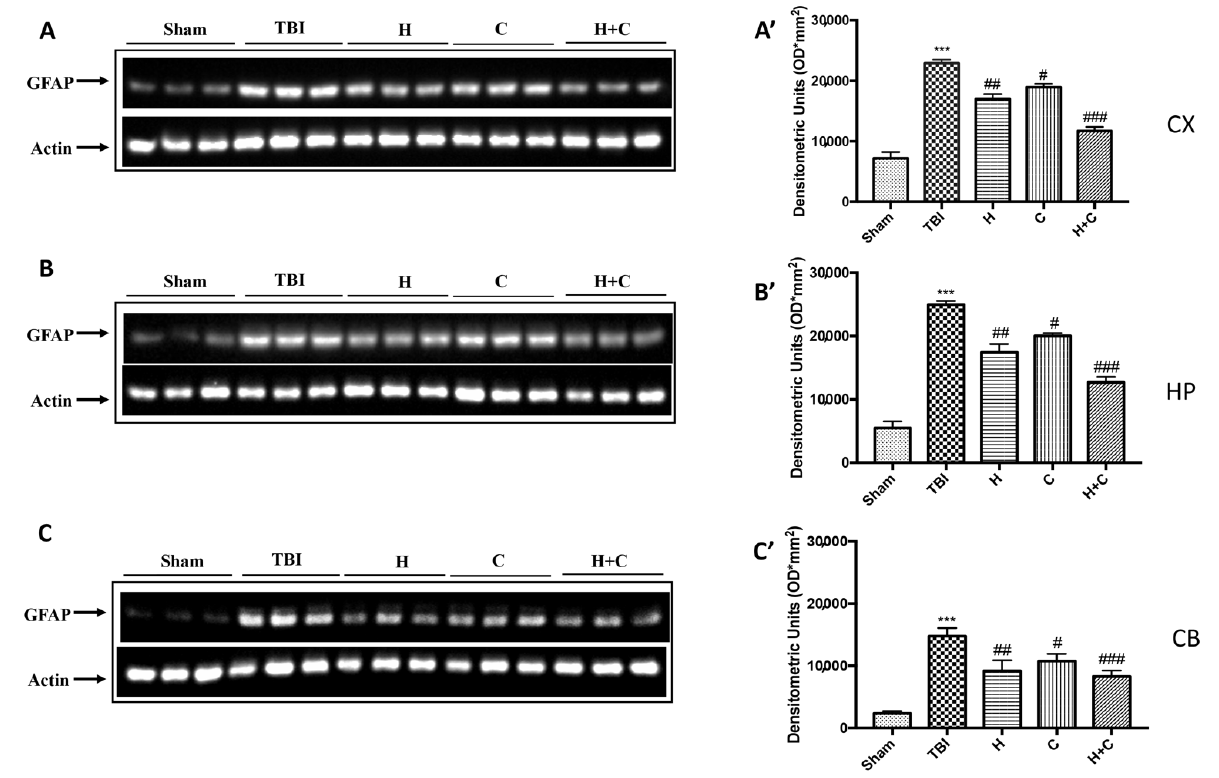
Figure 4. Effect of H. erinaceus or C. versicolor , or H. erinaceus + C. versicolor treatment on GFAP protein after chronic TBI. Western blot analysis showed that the expression of GFAP increased significantly in the TBI group in CX ( A ), HP ( B ) and CB ( C ) regions. H, C, and H + C treatment further significantly decreased the expression of GFAP in CX and HP regions ( A , B ); while in CB only H and H + C significantly decreased the expression of GFAP. The data are expressed as the mean SEM from n = 5 mice/group. Densitometry analysis: ( A’ ) *** p < 0.001 vs. Sham; ## p < 0.01 vs. TBI; # p < 0.05 vs. TBI; ### p < 0.001 vs. TBI; ( B’ ) *** p < 0.001 vs. Sham; ## p < 0.01 vs. TBI; # p < 0.05 vs. TBI; ### p < 0.001 vs. TBI; ( C’ ) *** p < 0.001 vs. Sham; ## p < 0.01 vs. TBI; # p < 0.05 vs. TBI; ### p < 0.001 vs. TBI.